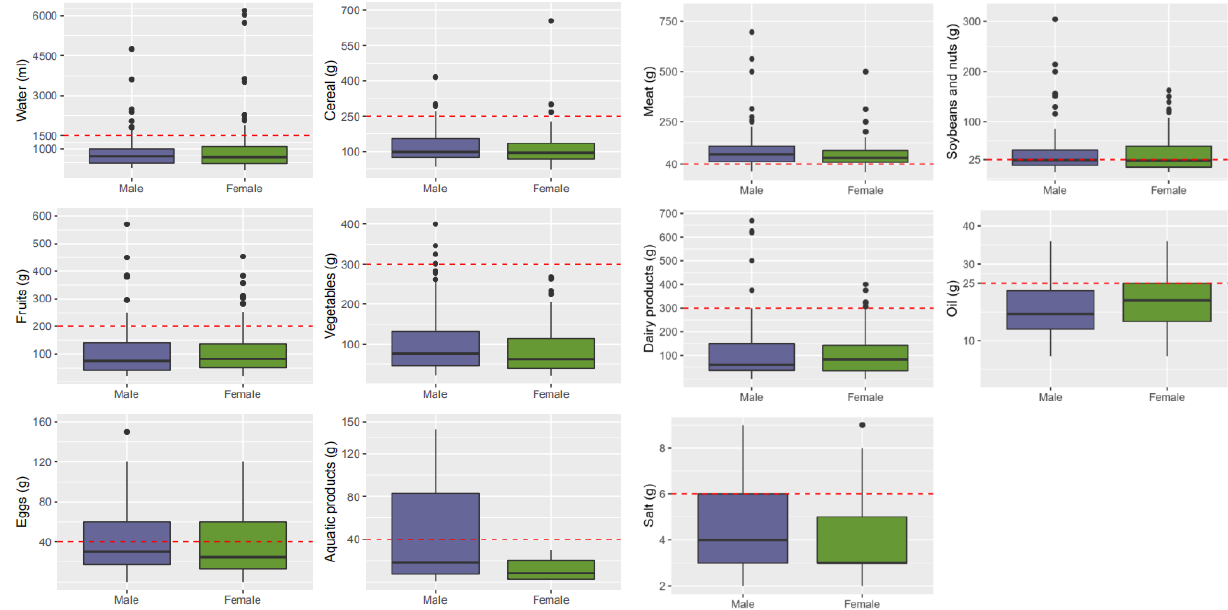
Figure 4. Dietary intakes of Tibetan local residents of different genders.